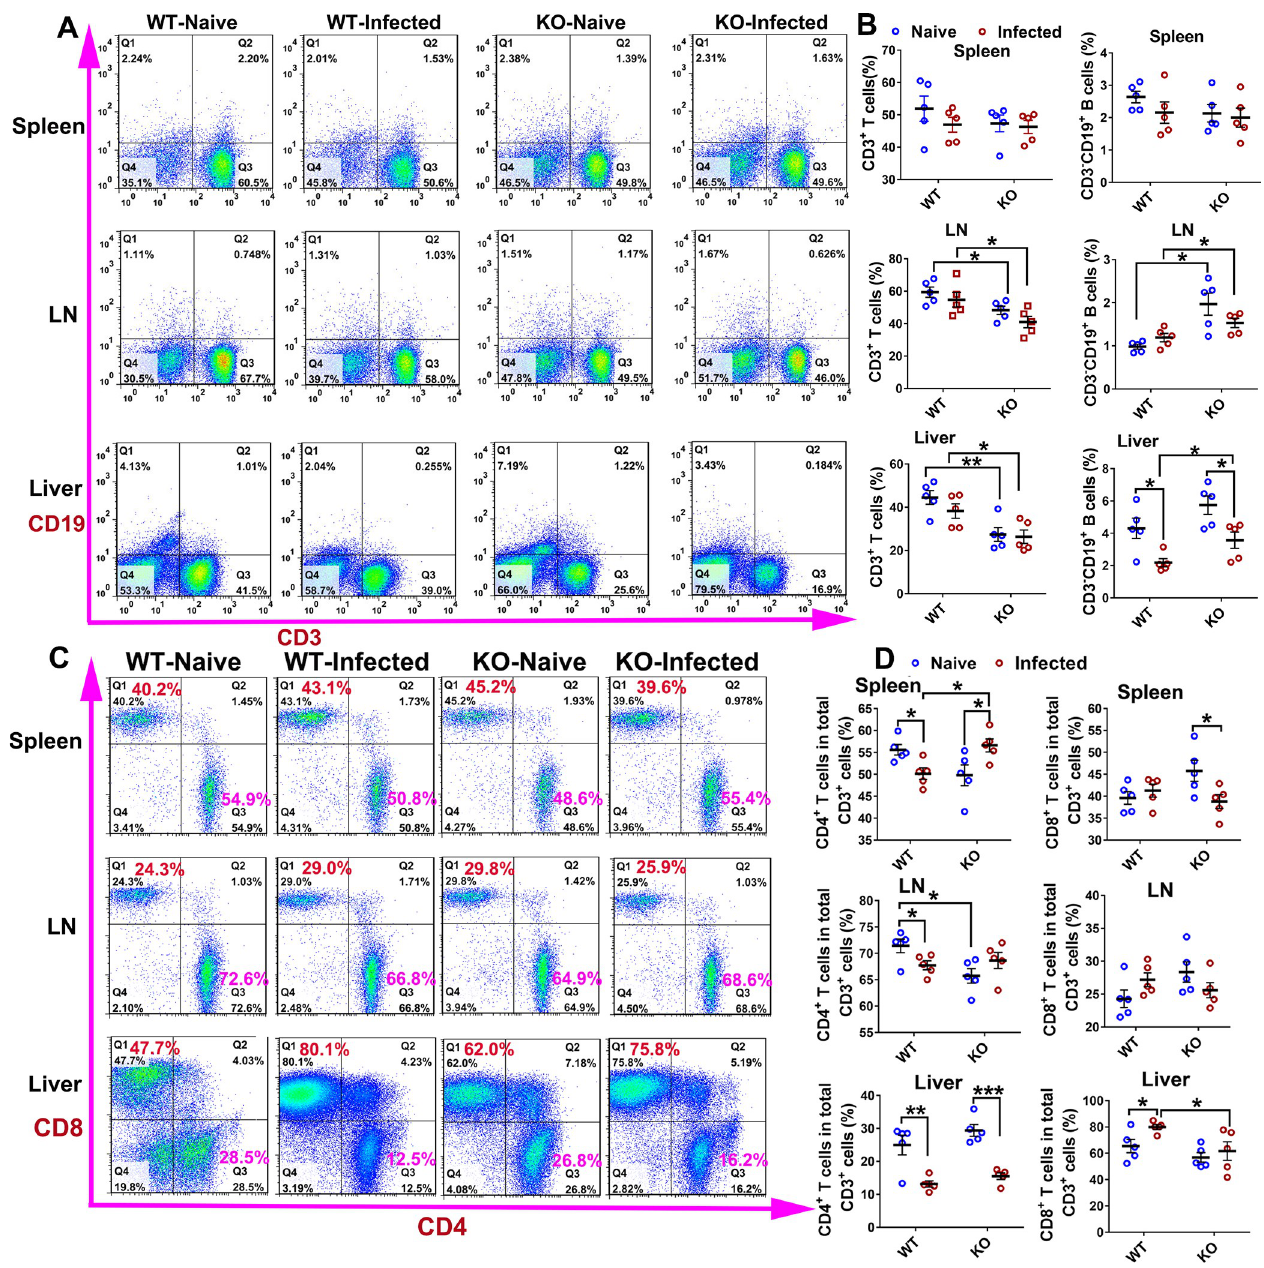
Fig 2. Flow cytometry analysis of the changes in T cell and B cell proportions in iNOS-KO and WT control rats. WT and KO rats were infected percutaneously with 200 S . japonicum cercariae and sacrificed at 7 weeks post-infection. (A) Representative FACS plots of CD3 + T cells and CD19 + B cells in the spleens, LN, and livers. (B) Frequency of CD3 + T cells and CD19 + B cells in the spleens, LN, and livers. (C) Representative FACS plots of CD4 + and CD8 + T cells in the spleens, LN, and livers. Numbers represent the frequency of the boxed population within the CD3 + T cell population. (D) Frequency of CD4 + and CD8 + T cells. Data shown are means ± SEM and repeated twice with similar results, n = 5 rats per group. Significant differences have been noted, � P < 0.05, �� P < 0.01, ��� P < 0.001. SP = Spleen, LN = lymph